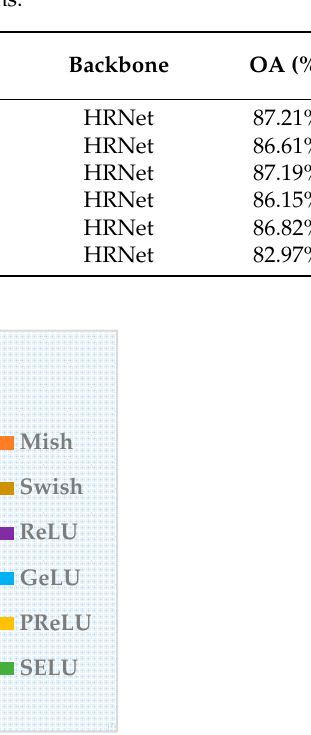
Table 2. Ablation Study Result of different activation functions.